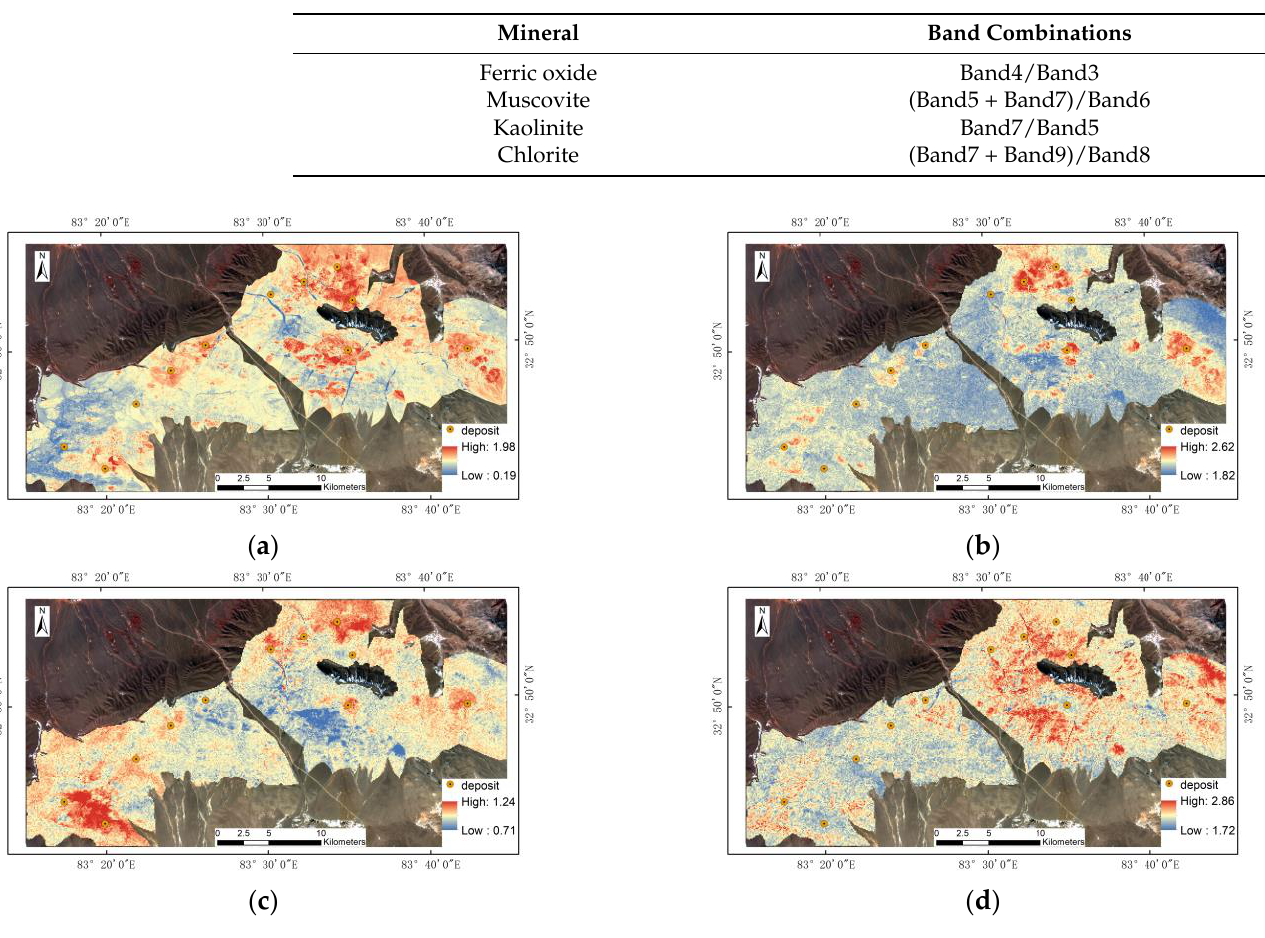
Table 1. Band combinations for enhancing mineral features on the ASTER dataset.